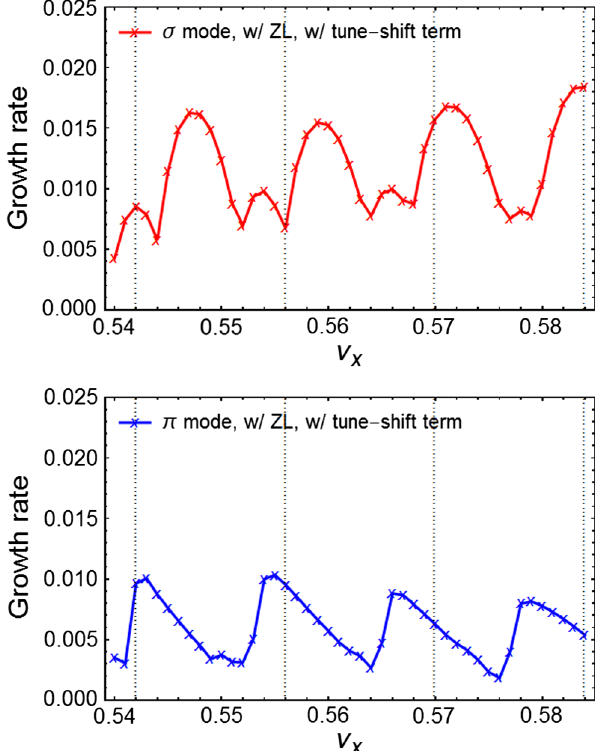
18. Growth rate vs horizontal tune, where we also consider the second tune-shift term of Eq. (22) and longitudinal impedance (ZL). The red and blue points represent the σ and π modes,